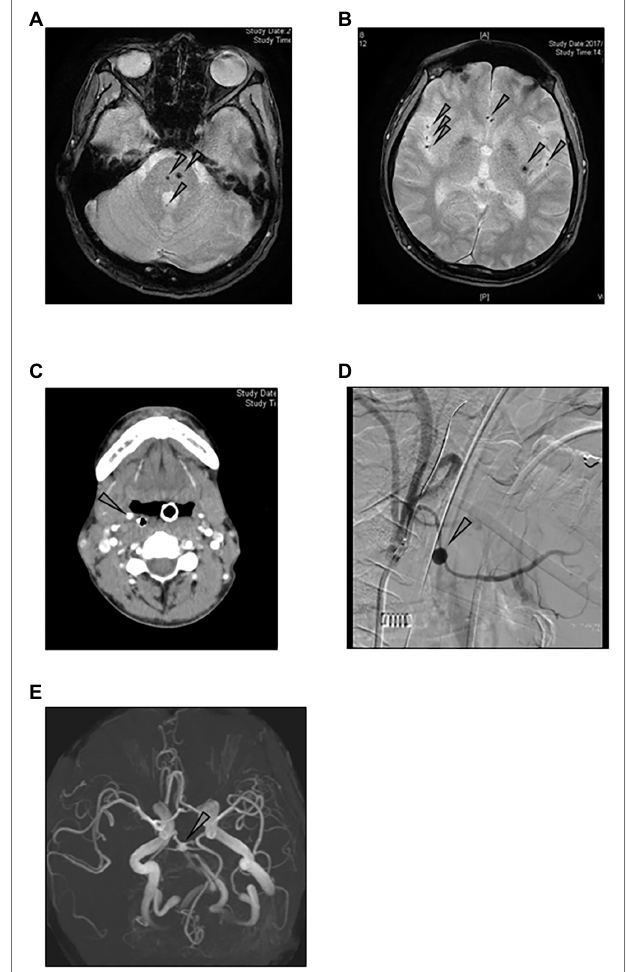
FIGURE 2 | Image findings of sCAEBV patients who had angiopathy. (A,B) Magnetic resonance imaging of the brain of patient 2: Multiple cerebral (A) and cerebellar (B) micro bleeding were detected by T2 star-weighted images (arrows). (C,D) Images of patient 7: Contract-enhanced CT examination shows the dilatation of the right hyoid artery (C) . Angiography shows the right hyoid artery aneurysm (D) . (E) Magnetic resonance angiography of patient 9: Aneurysm was suspected because of narrowing and dilation of vertebral